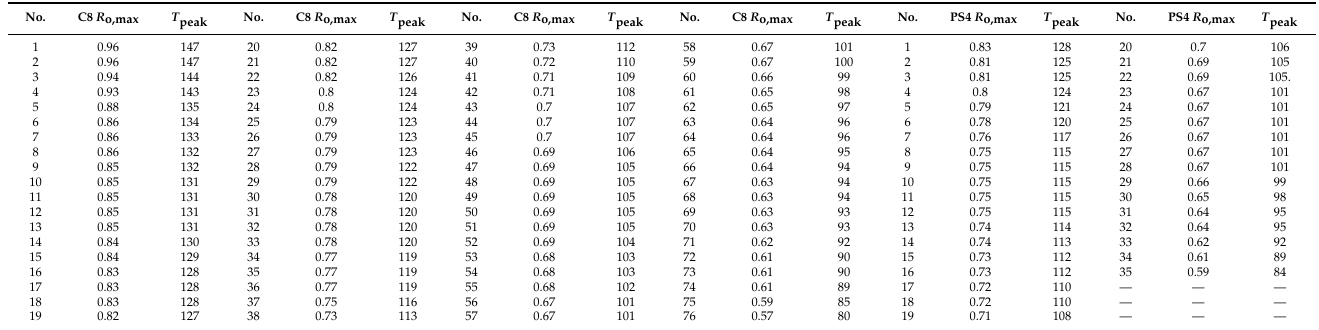
Table 1. The maximum vitrinite reflectance (% R o,max ) and the paleotemperature ( T peak / ◦ C).